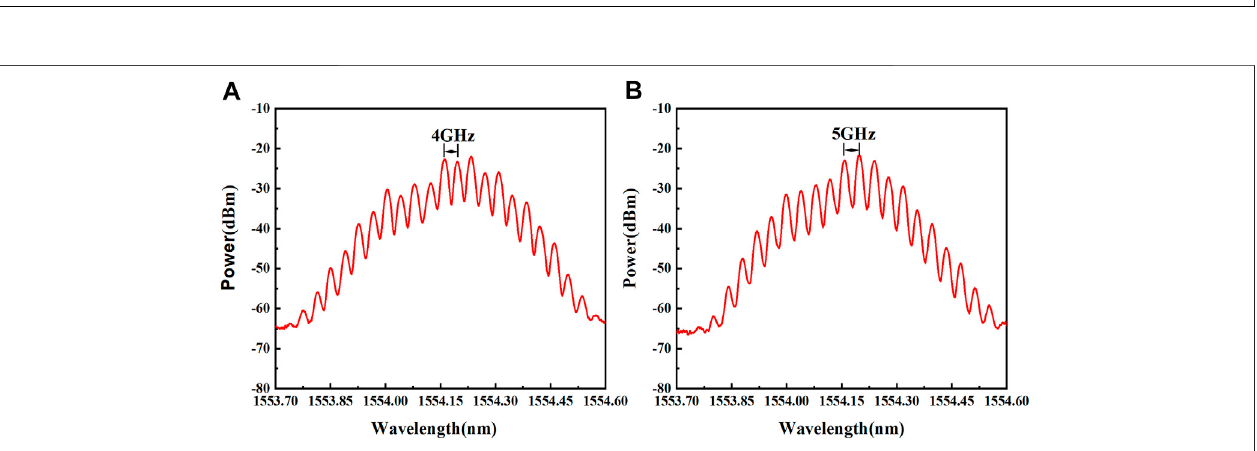
Frontiers in Physics |